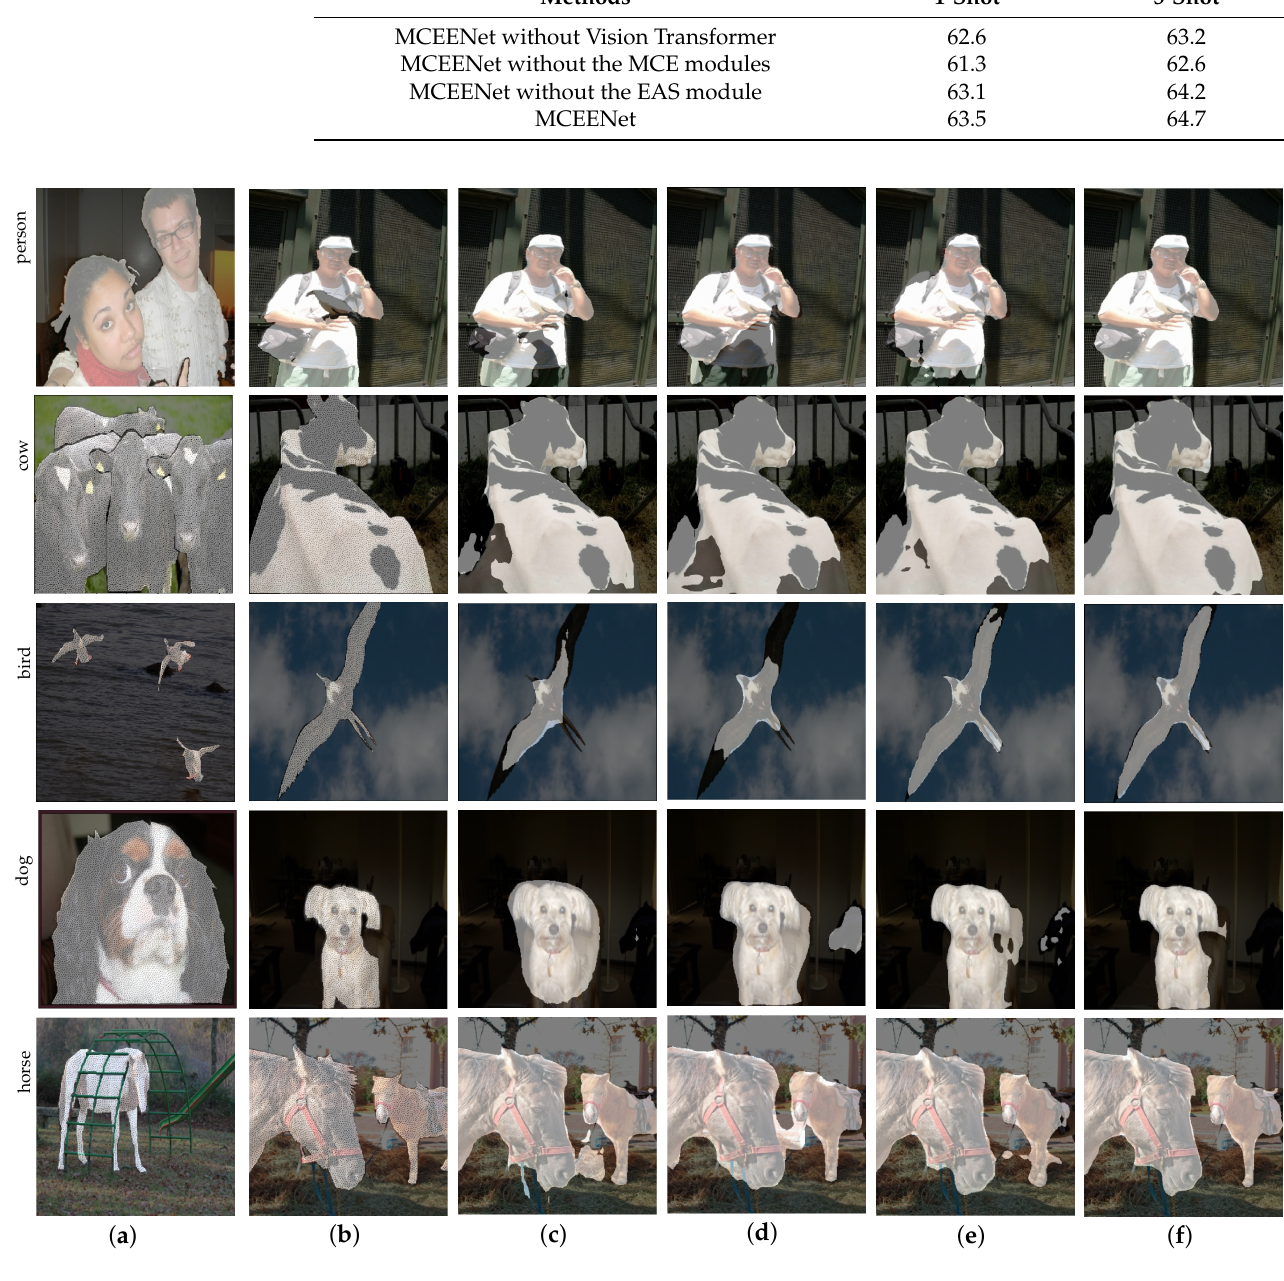
Figure 5. Qualitative ablation results in 1-way 1-shot segmentation on PASCAL-5 i . Specifically, the first column is the support images with ground-truths, the second column is the query images with ground-truths, and the third, fourth, fifth, and sixth columns are the segmentation results of the query images obtained by MCEENet without Vision Transformer, MCEENet without the MCE modules, MCEENet without the EAS module, and MCEENet, respectively. ( a ) support; ( b ) ground-truth; ( c ) MCEENet without Vision Transformer; ( d ) MCEENet without the MCE modules; ( e )